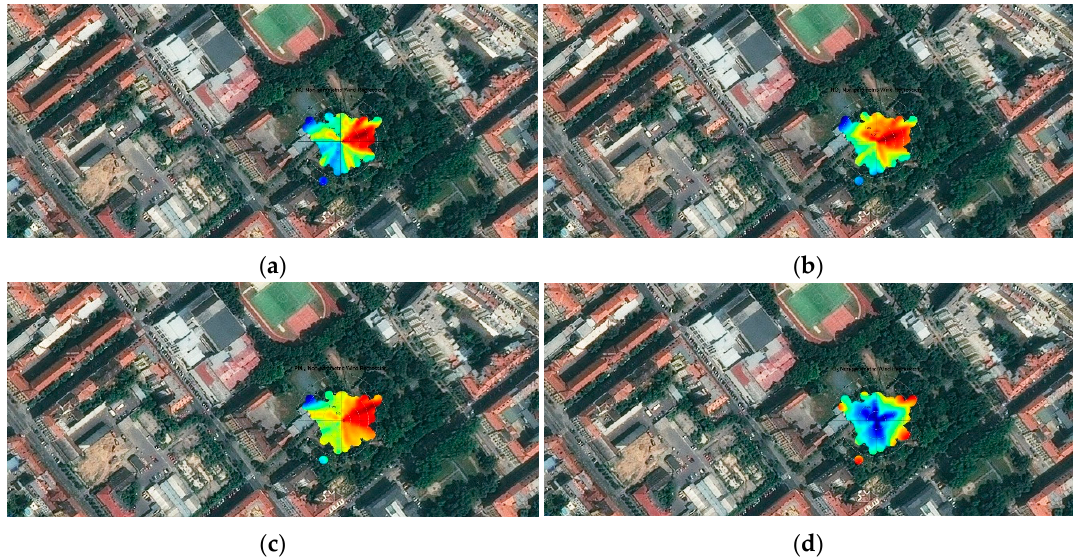
Figure 18. The NO ( a ), NO 2 ( b ), PM 10 ( c ), and O 3 ( d ) concentration relationships to the wind speed and direction at Tyrš ů v sad; sampling started on 2.8.2019 7:00 .